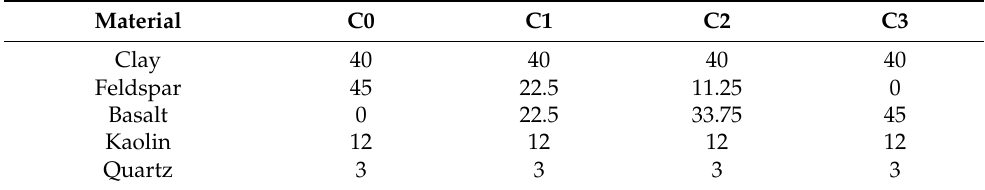
Table 1. Compositions studied